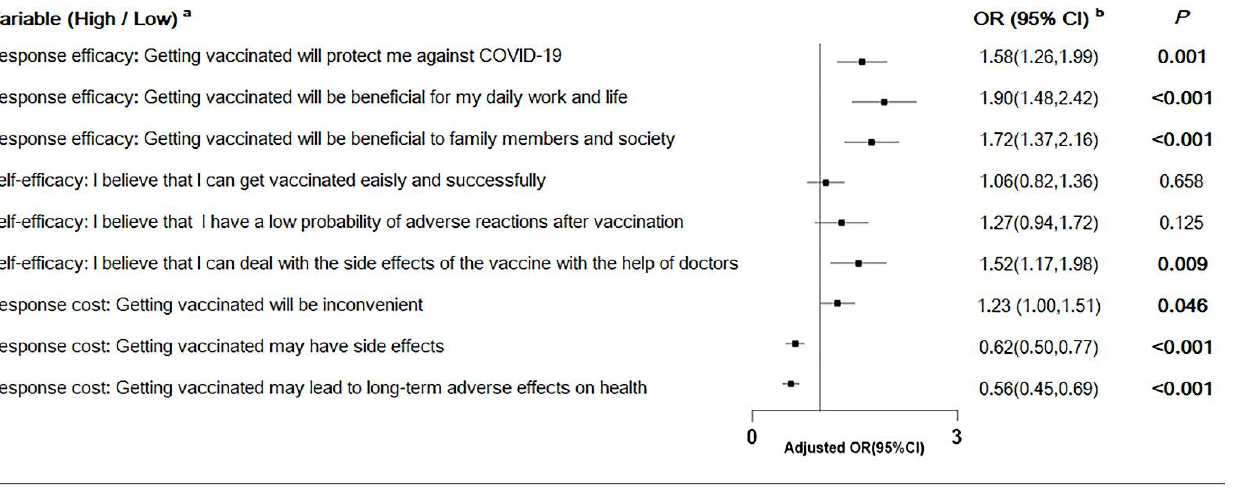
Figure 2. Multiple logistic regression for specific items predicting the willingness to receive the COVID-19 vaccine. ( a The perceived degree of each item was obtained (range 1 – 5), and the median of each item index was used for binary categorical classification (high/low level). b OR was adjusted for age, sex, occupation, region, self-rated overall health, the number of chronic diseases, and all the psychosocial factors).